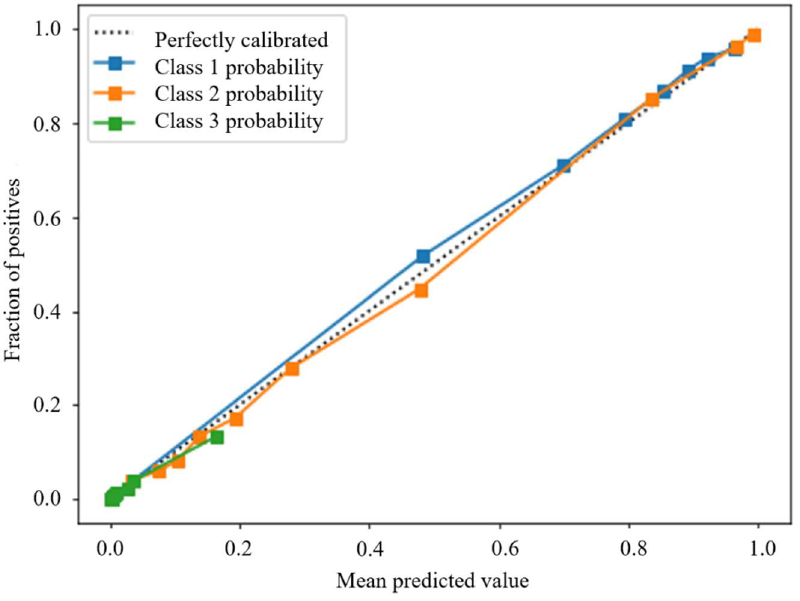
Figure 8. Probability plot of 3 classes after calibration.